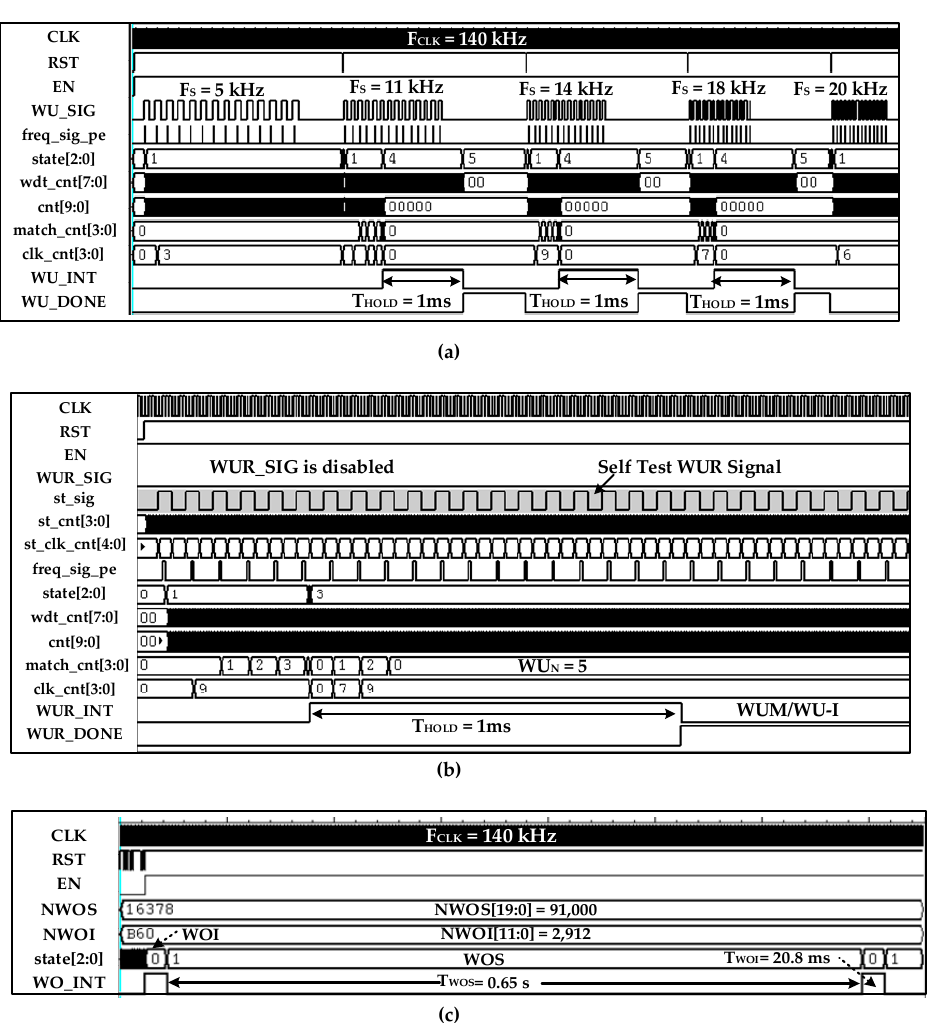
Figure 21. The IDC post place and route (P&R) simulation result: ( a ) WU/WU-I with different wake-up frequencies; ( b ) self-test with WU_I; ( c ) wake-on mode with interrupt and sleep durations of 20.8 ms and 0.65 s.